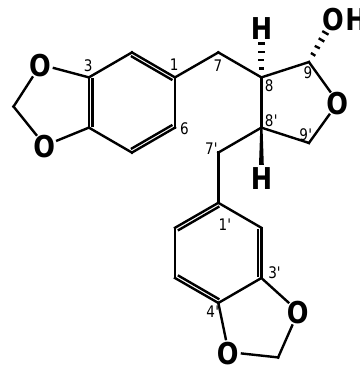
Figure 7. Chemical structure of 8, 8′ trans-cubebin ( 3 ) . Table 1. NMR spectroscopy data ( 1 H and 13 C, in CDCl 3 ) of compounds 2 and 3.